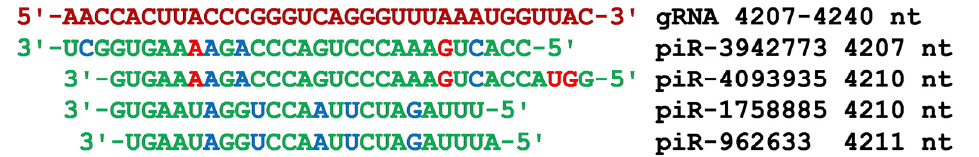
Figure 4. Nucleotide sequences of the piRNA BSs cluster in the CDS of gRNA from 4207 nt to 4241 nt and the nucleotide sequences of four piRNAs. Note: The piRNA nucleotides that form canonical pairs with gRNA are highlighted in green and non ‐ canonical pairs are highlighted in blue. The piRNA nucleotides that do not interact with gRNA are highlighted in red. The names of the piRNAs are followed by the beginning of their BSs.